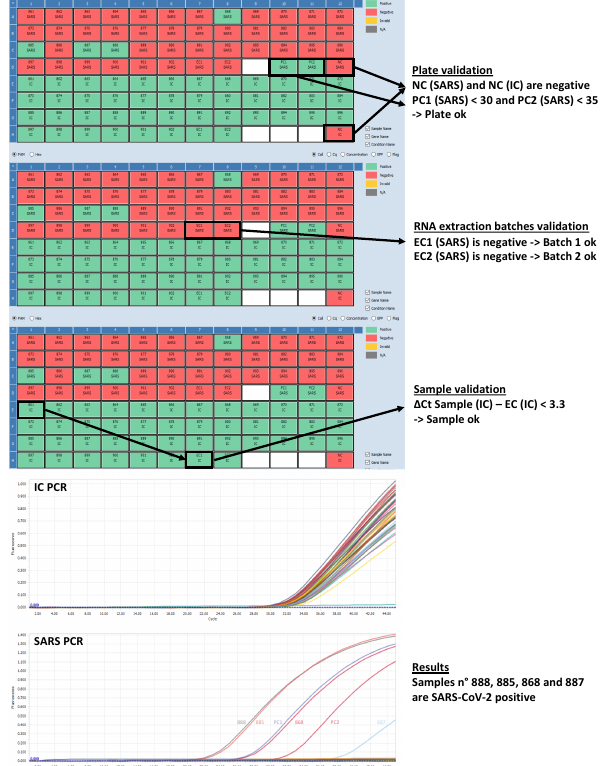
Figure 7: Anticipated results